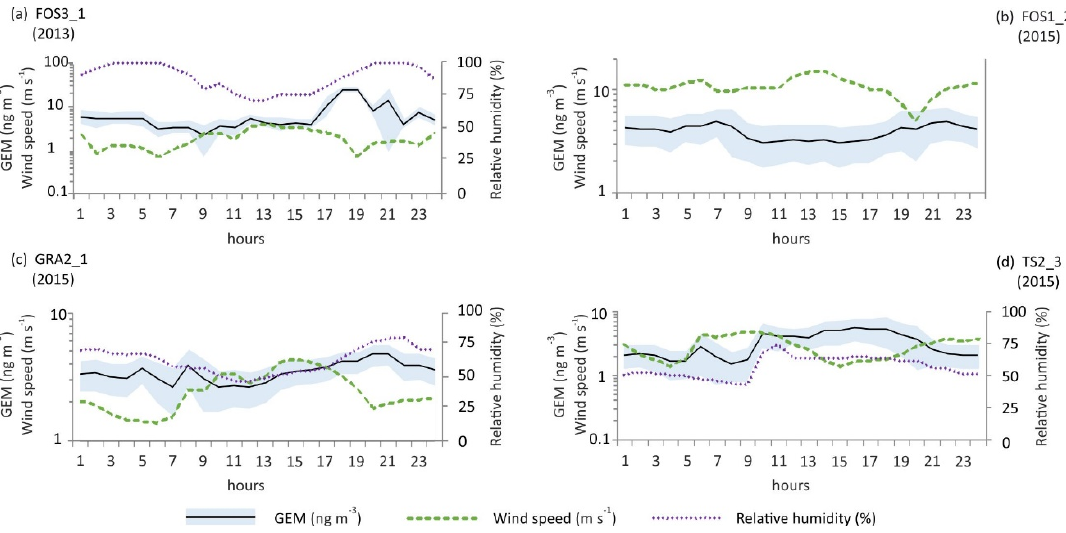
Figure 4. Hourly average values of GEM (ng m − 3 ) plotted against wind speed (m s − 1 ) and relative humidity at selected sites. ( a , b ) Fossalon Hg-contaminated site; ( c ) Grado Hg-contaminated site; ( d ) Trieste urban area. Table 2. Spearman (r) correlation matrix between GEM concentrations and micrometeorological parameters. Dark blue and red indicate strong negative and positive significant correlations.